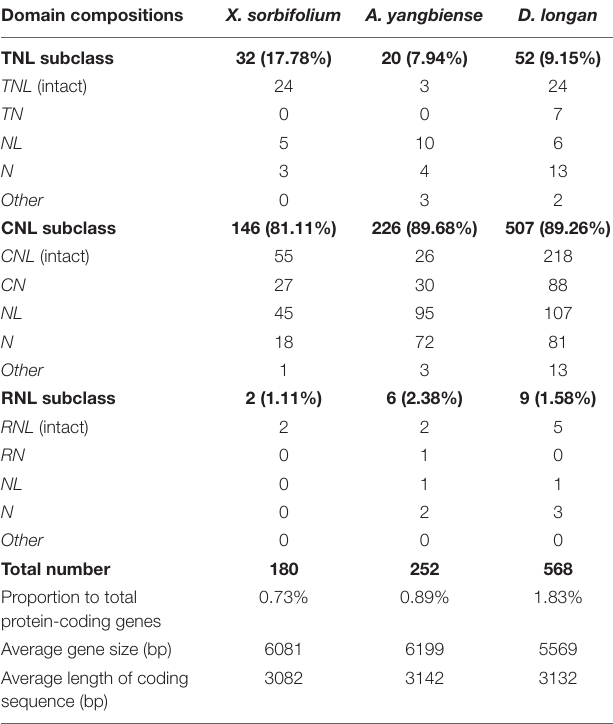
TABLE 1 | The number of identified NBS-encoding genes in the three Sapindaceae genomes. Domain